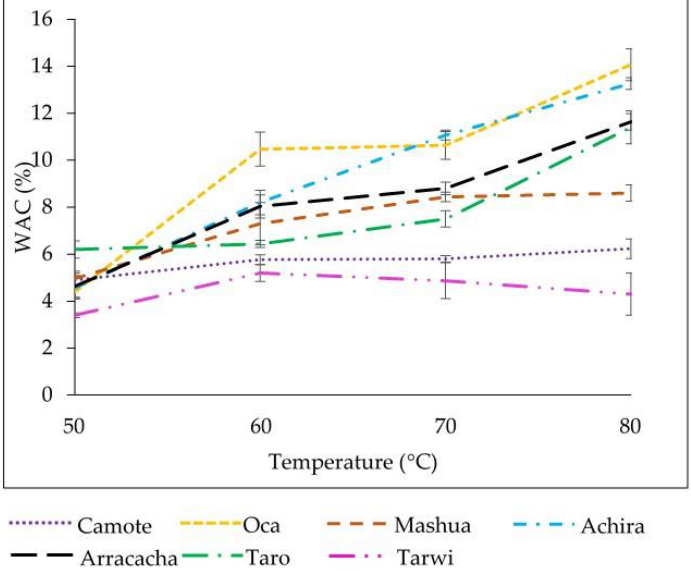
Figure 4. Water absorption capacity (WAC) of flours as a function of the temperature (50 – 80